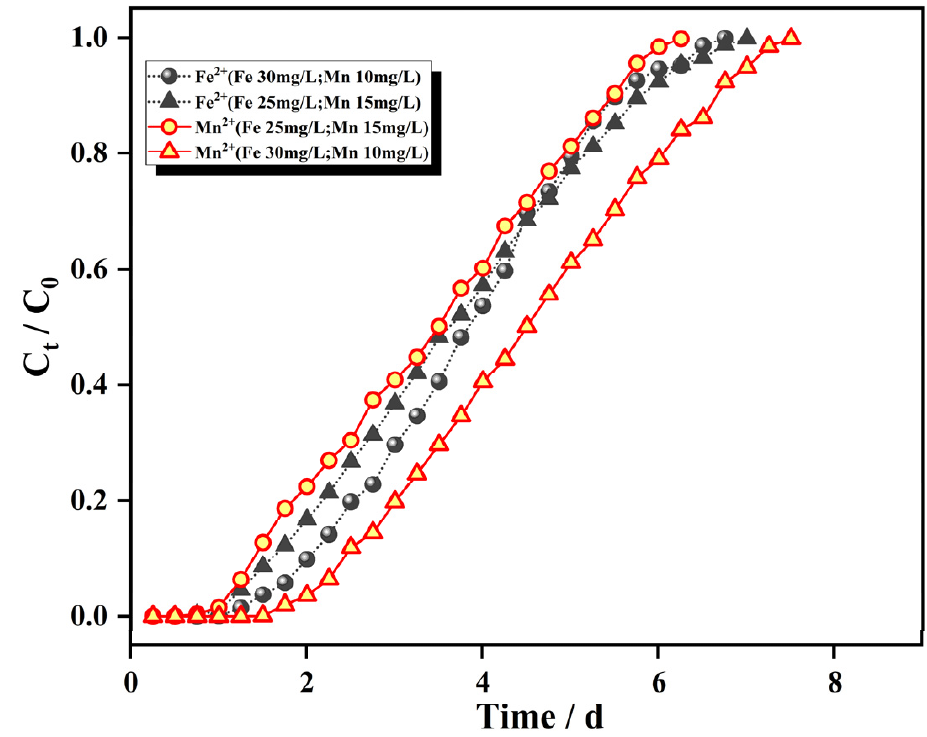
Figure 9. Breakthrough curves for different initial concentrations.